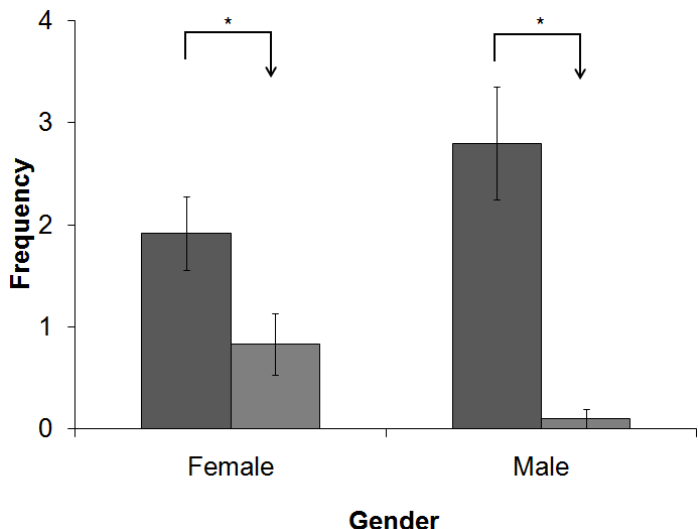
Figure 5. Frequency of entry into the refuges at 0.0 m (dark bars) and 0.5 m (light bars). Females and males entered the boxes at 0.0 m at significantly greater frequencies than those at 0.5 m ( * p < 0.05).